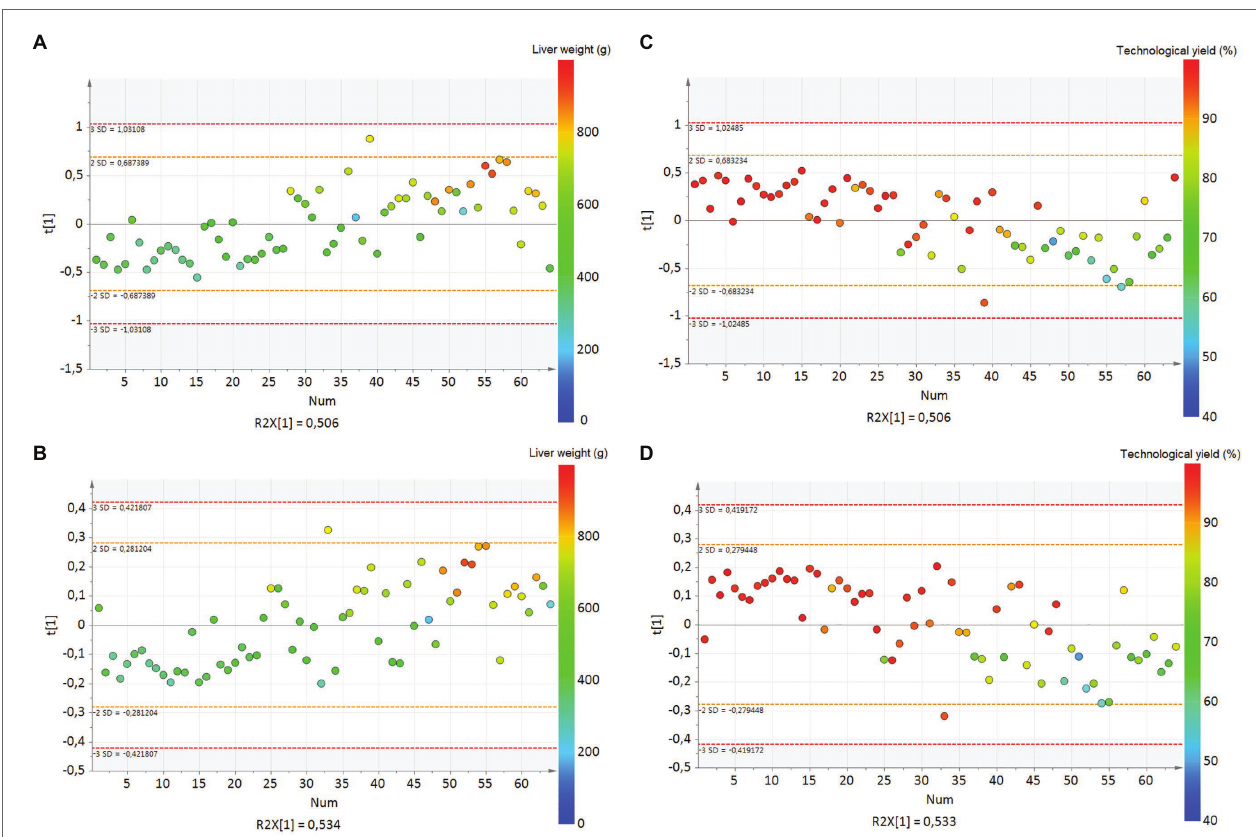
FIGURE 2 | PLS score plots (A) for liver weight with the bucket method (R 2 X = 0.506, R 2 Y = 0.657, Q 2 = 0.633) and (B) with the metabolite method (R 2 X = 0.534, R 2 Y = 0.65, Q 2 = 0.626), (C) for liver technological yield with the bucket method (R 2 X = 0.506, R 2 Y = 0.514, Q 2 = 0.471), (D) for liver technological yield with the metabolite method (R 2 X = 0.533, R 2 Y = 0.522, Q 2 = 0.418). The numbers correspond to the identification of the samples and the colors to the liver weight value. The legend is indicated on the right of the figure. The numbers correspond to the identification of the samples on the X axis and the colors to the liver weight or technological yield